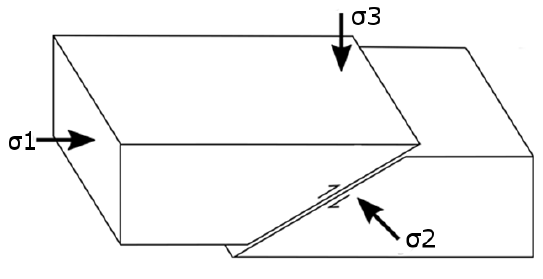
Figure 15. Andersonian notation for the reverse fault regime.